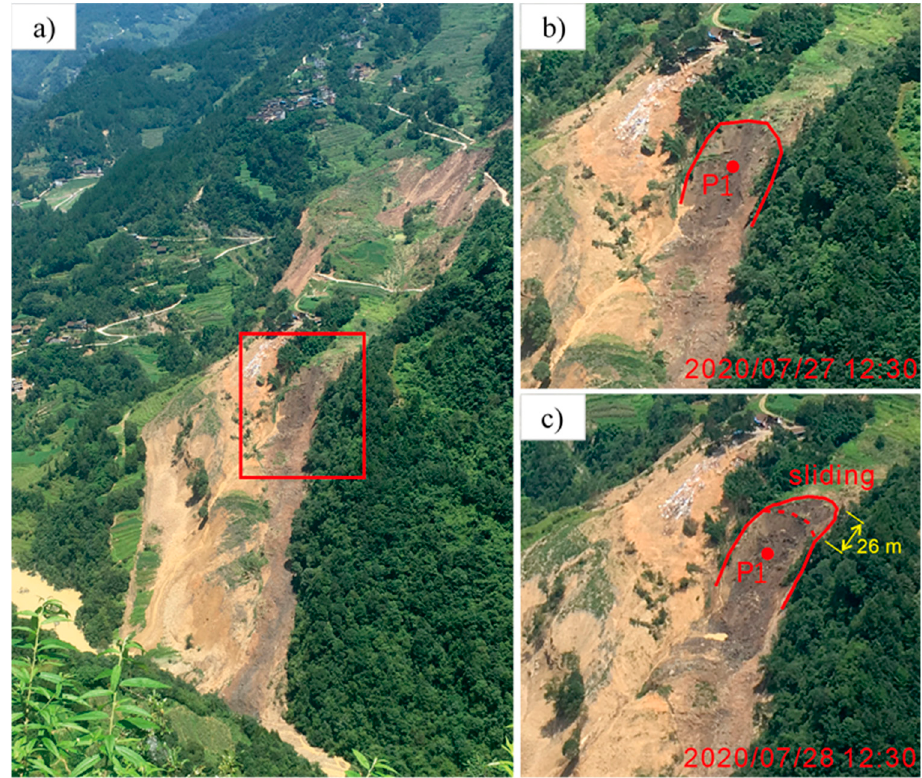
Figure 8. Optical image of the Zhongbao landslide. ( a ) The location of the deformation zone. ( b ) Deformation zone at 12:30 on July 27. ( c ) Deformation zone at 12:30 on July 28.